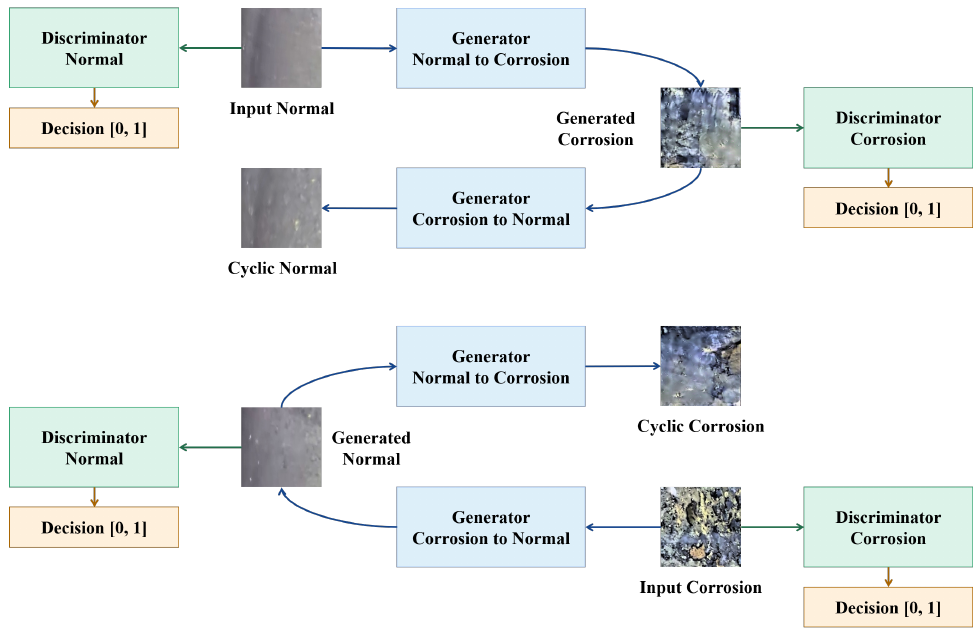
Figure 4. The flowchart of the cycle-GAN